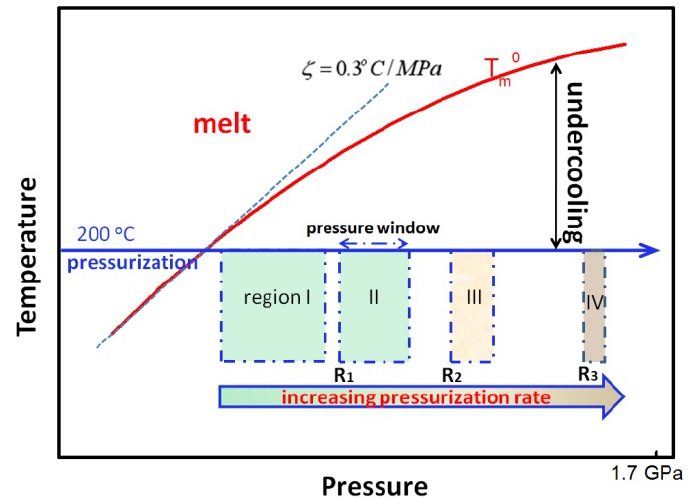
Figure 8. Theoretical model of the pressurization induced crystallization of β -NA blended iPP in the pressure–temperature diagram.